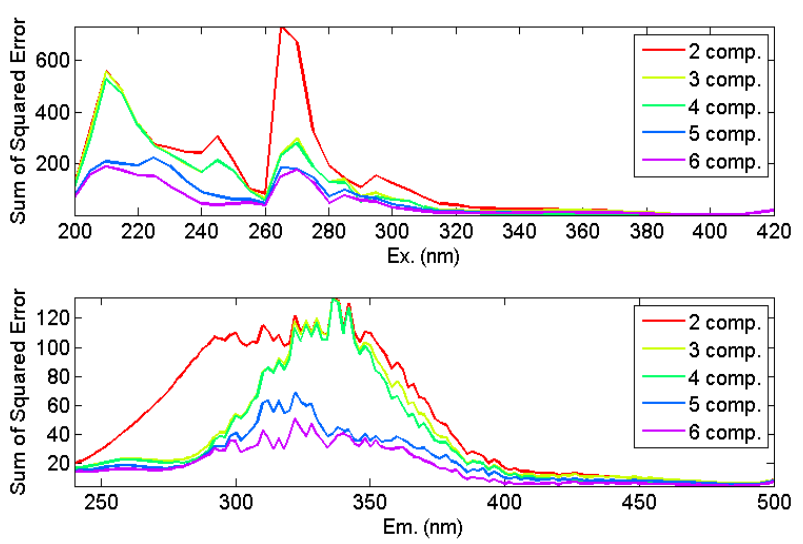
Figure 3. The sum of squared error of the three-dimensional excitation-emission matrix (3DEEM) fluorescence spectroscopy excitation and emission spectra for geothermal water from a depth of less than 1200 m.